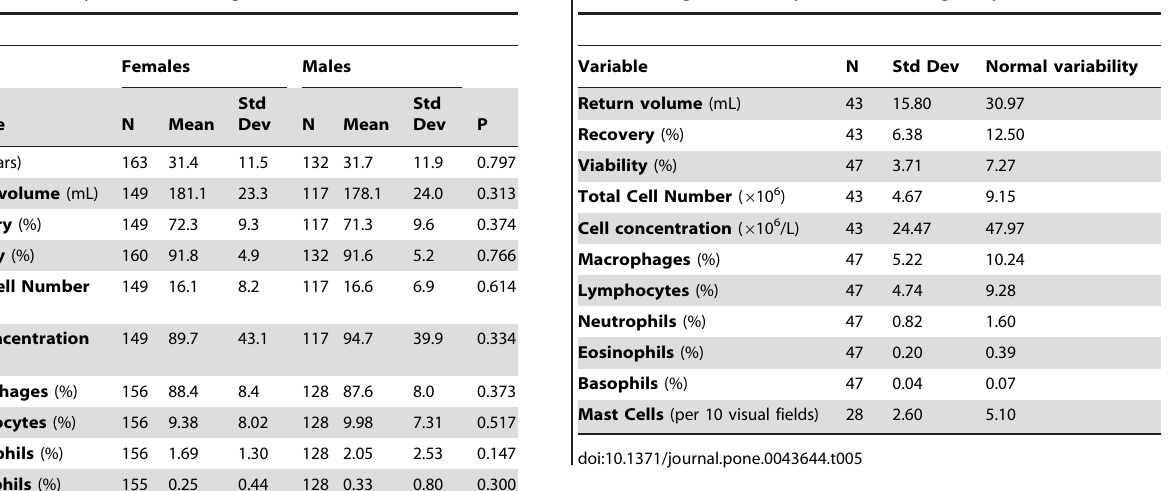
Table 5. Intraindividual variability of bronchoalveolar lavage fluid findings in healthy never-smoking subjects.